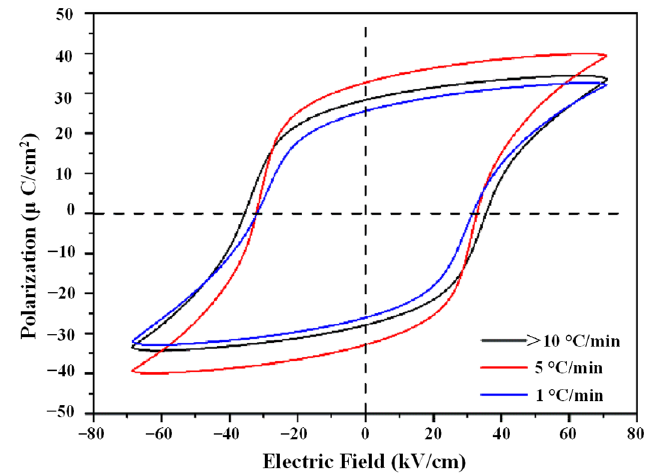
Figure 2. Hysteresis curves of piezoelectric ceramics.